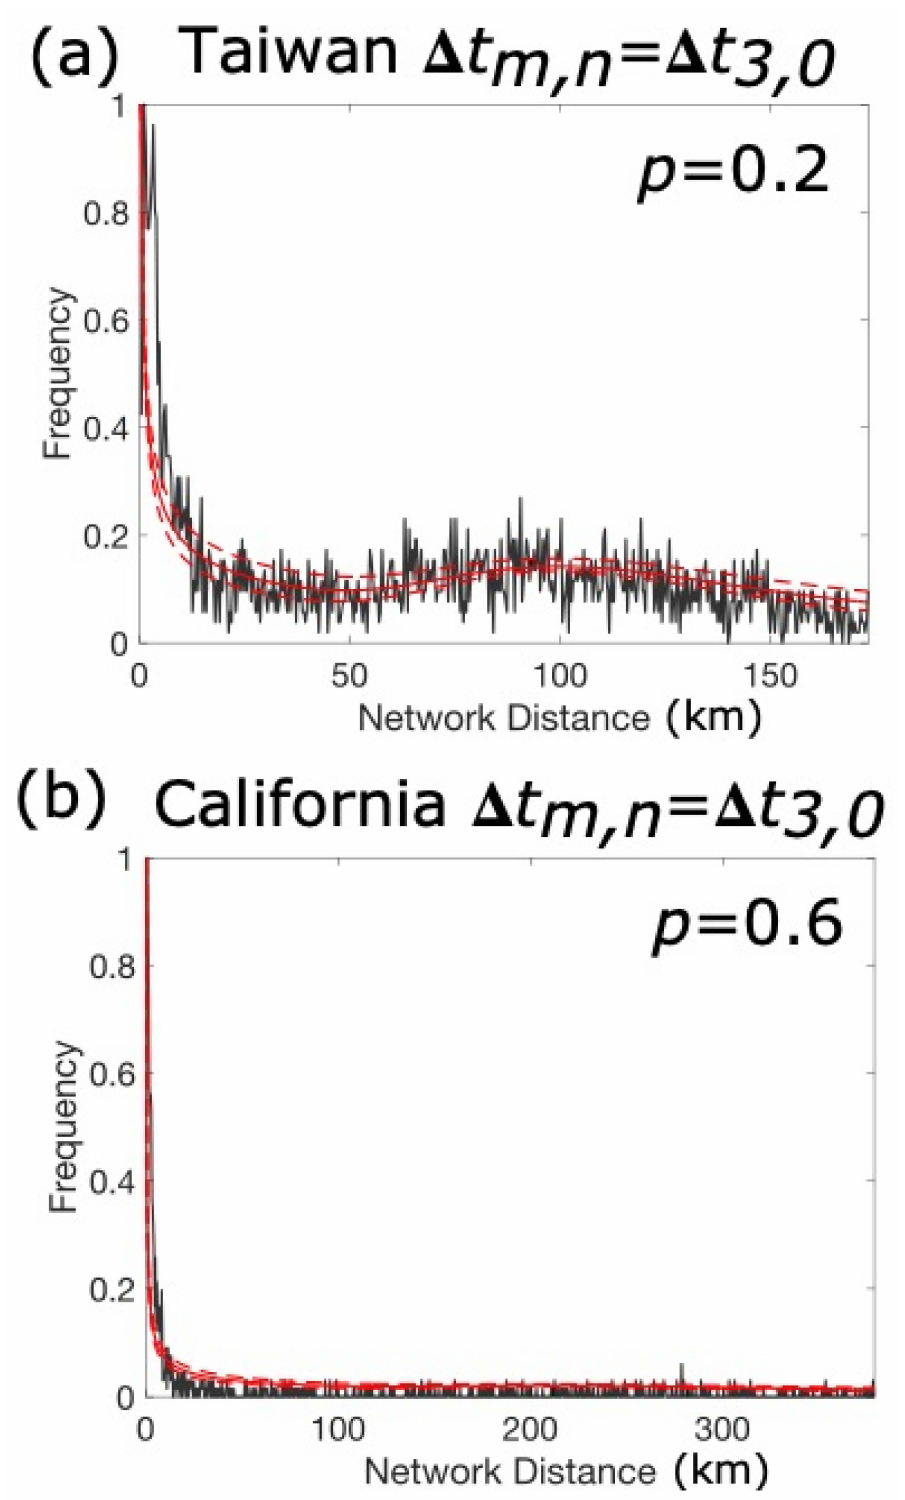
Figure 5. Frequency distribution of network distances for 3.0 < M ≤ 3.1 earthquakes in ( a ) Taiwan and ( b ) California occurring within the average interevent time ( n = 0) and fitting results. The red solid lines show the predicted bimodal distributions, the red dashed lines show the 95% confidence interval, and the parameter p is as